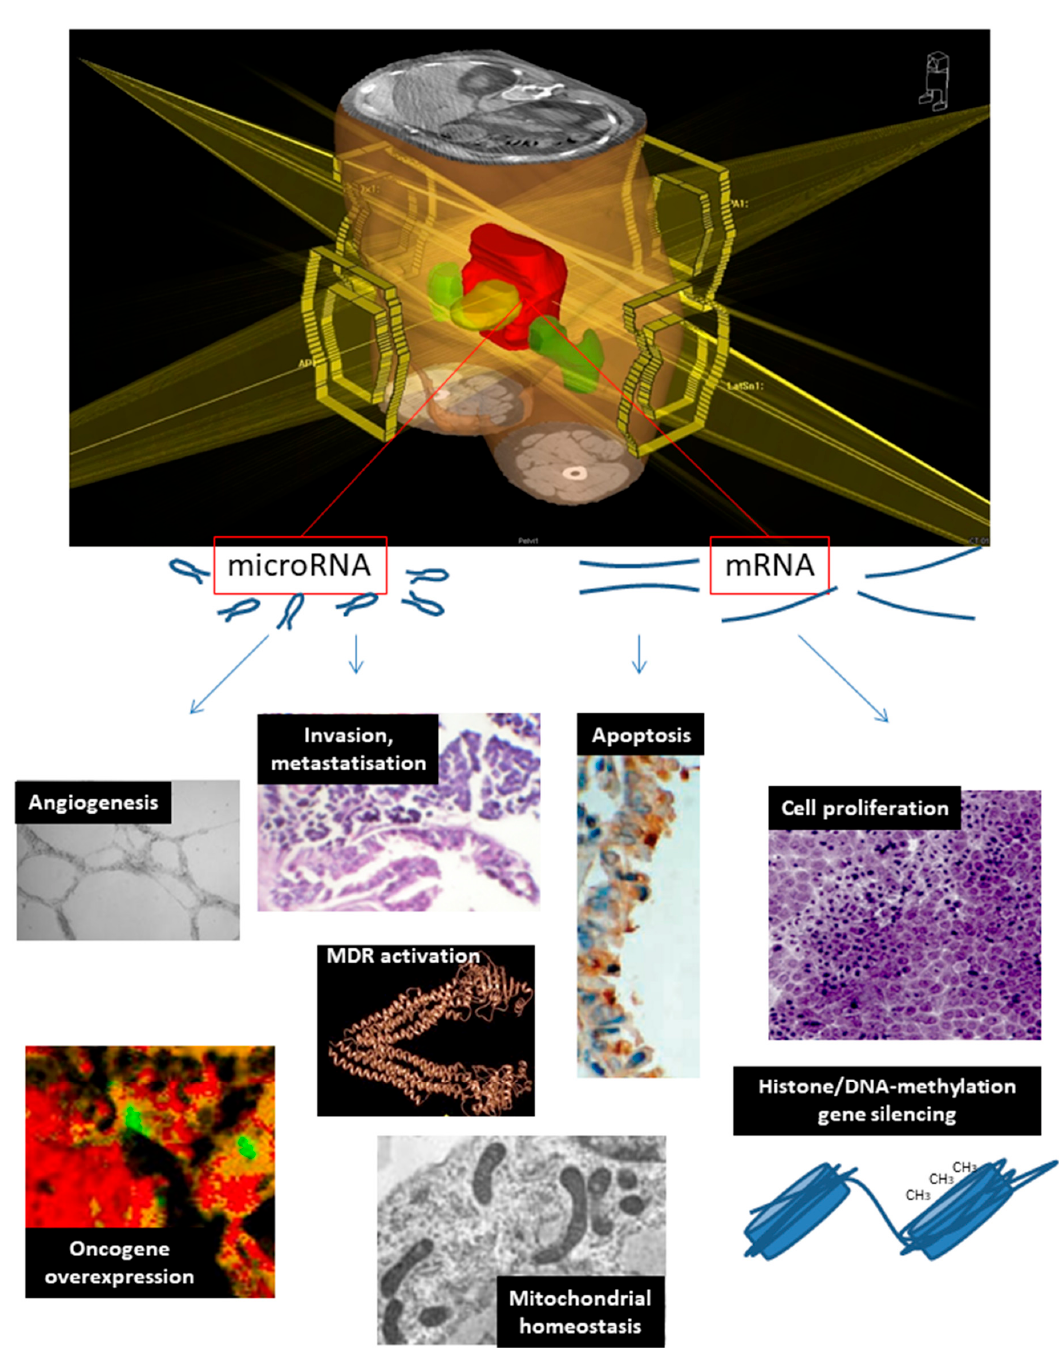
Figure 2. Biological functions of mRNA / miRNA predicting response of colon–rectal cancer to neoadjuvant therapy. The setting of radiation-based neoadjuvant therapy for colon–rectal cancer is shown in the upper panel, reporting converging radiation beams (yellow) and targeted cancer tissue (red). mRNA / miRNA response to neoadjuvant therapy, reflecting on biological processes (lower panels) and thus conditioning its e ffi